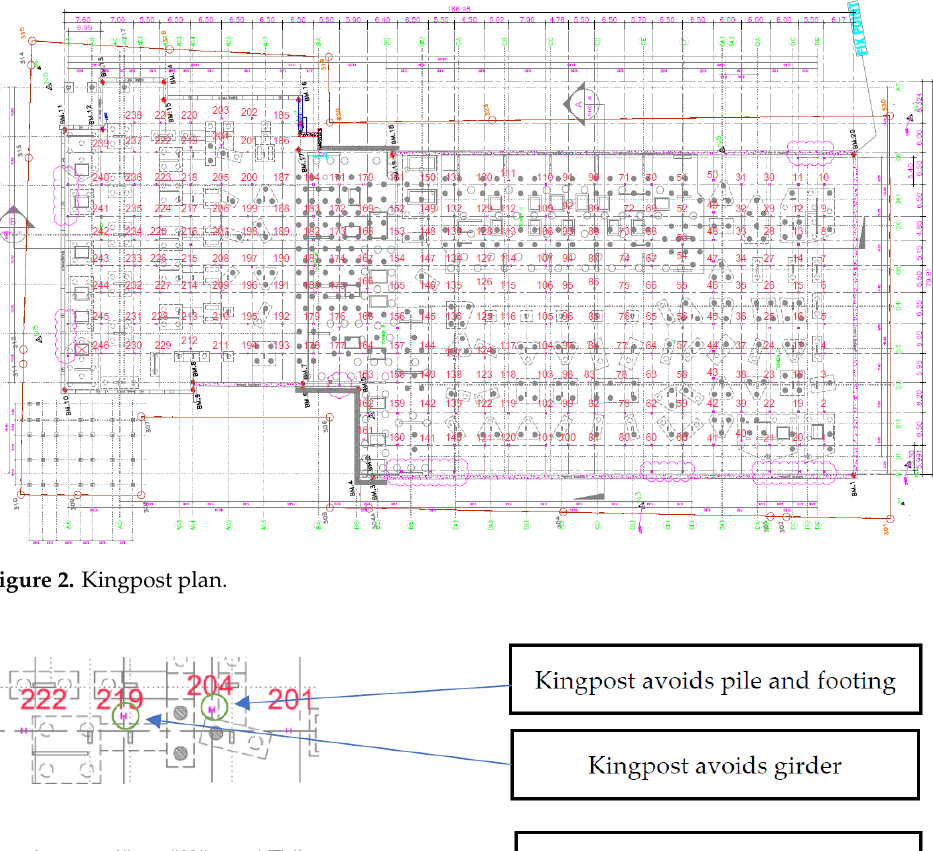
Figure 3. Examples of clash avoidance between kingpost and underground structure.